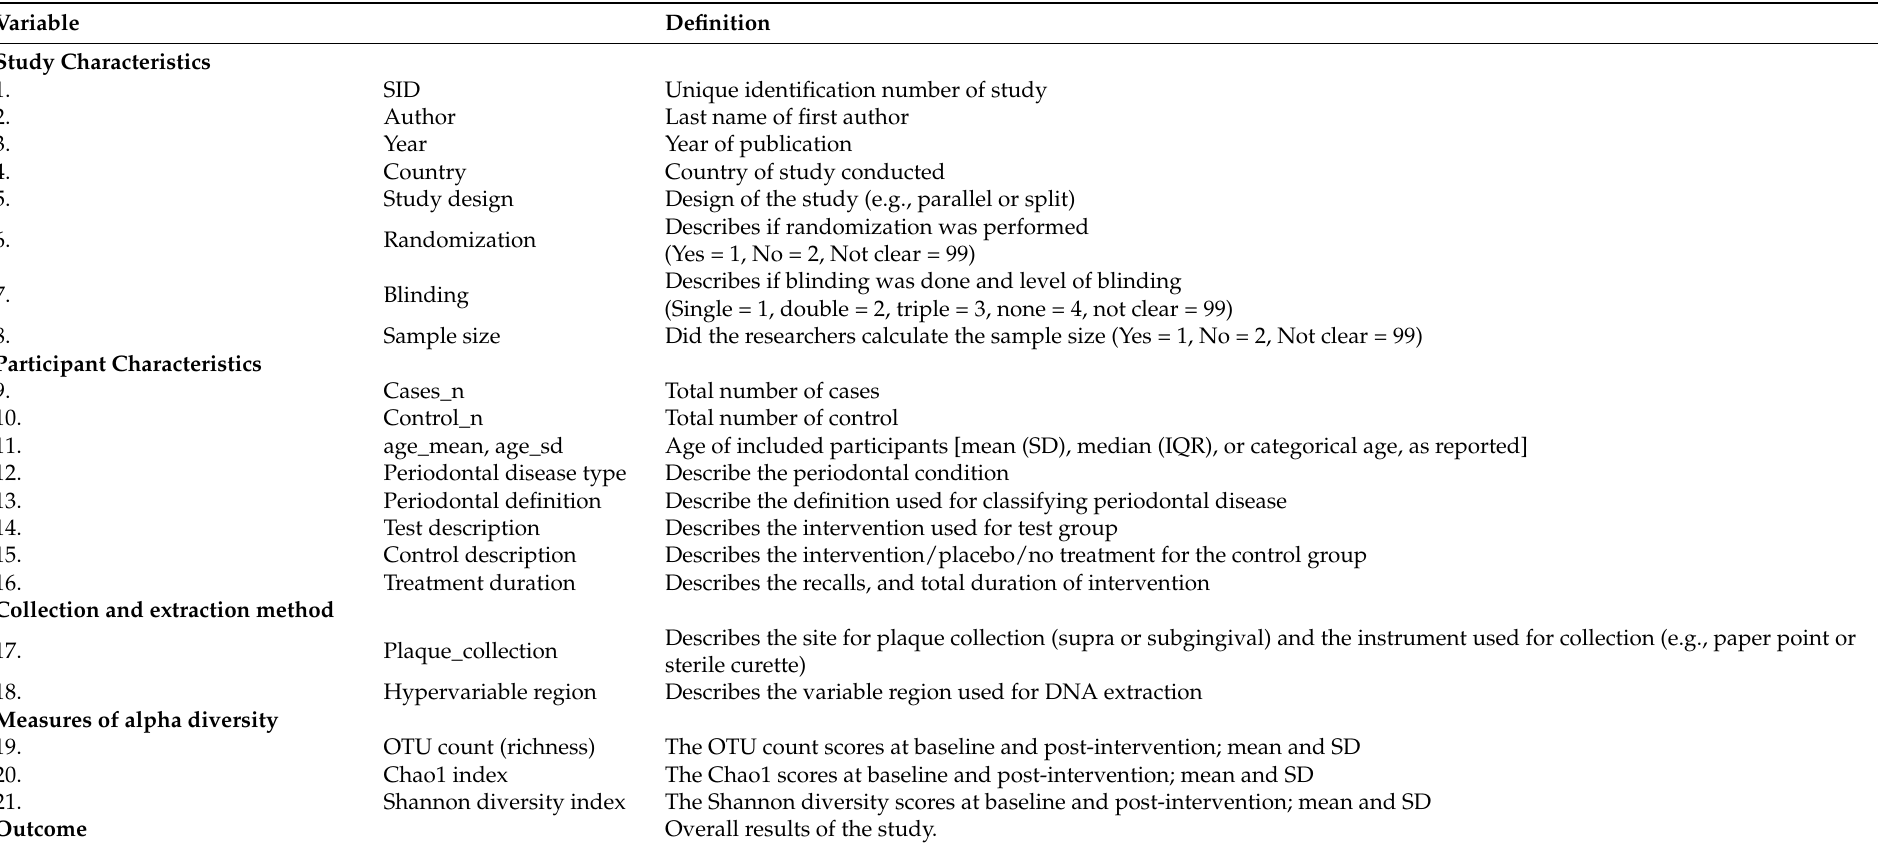
Table A2. Data extraction